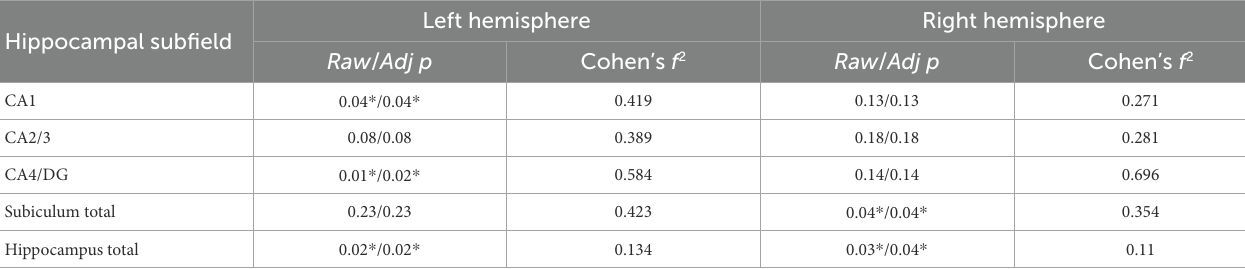
FIGURE 4 Regression plots of the identified significant negative associations between hippocampus subfield CA1, combined CA4/DG, total subiculum, left whole hippocampus, and right whole hippocampus and life stressors rated by the LSC.